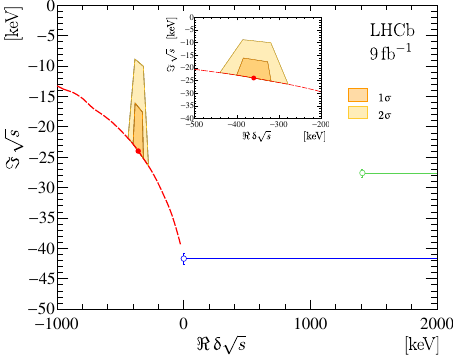
ffiffi p ffiffi p s Fig. 5 Complex plane of the δ s variable. Complex plane of the δ variable. The dashed red line shows the allowed region for large g j j values. The fi lled red circle indicates the best estimate for the pole location and the fi lled regions show 1 σ and 2 σ con fi dence regions. Open blue and green circles show the branch points corresponding to the D * + D 0 and D *0 D + channels, respectively, and the corresponding blue and green lines indicate branch